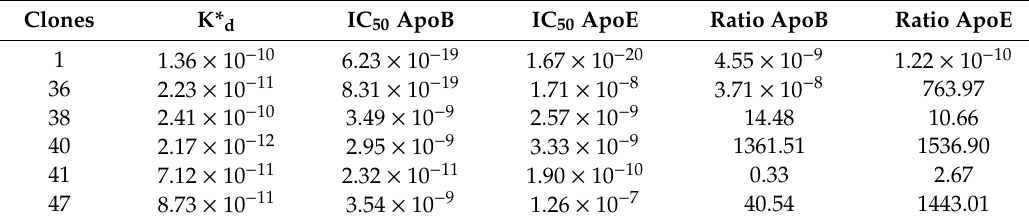
Table 2. Apparent dissociation constant ( K* d ) of selected clones, half-maximal inhibitory concentration (IC 50 ) of apolipoproteins B (ApoB) and E (ApoE), and ratios IC 50 / K* d , reflecting the inhibitory e ff ects of ApoB and ApoE on the clones’ binding. The IC 50 / K* d value was directly proportional to the strength of the clones’ binding to the extracellular domain of LDLR